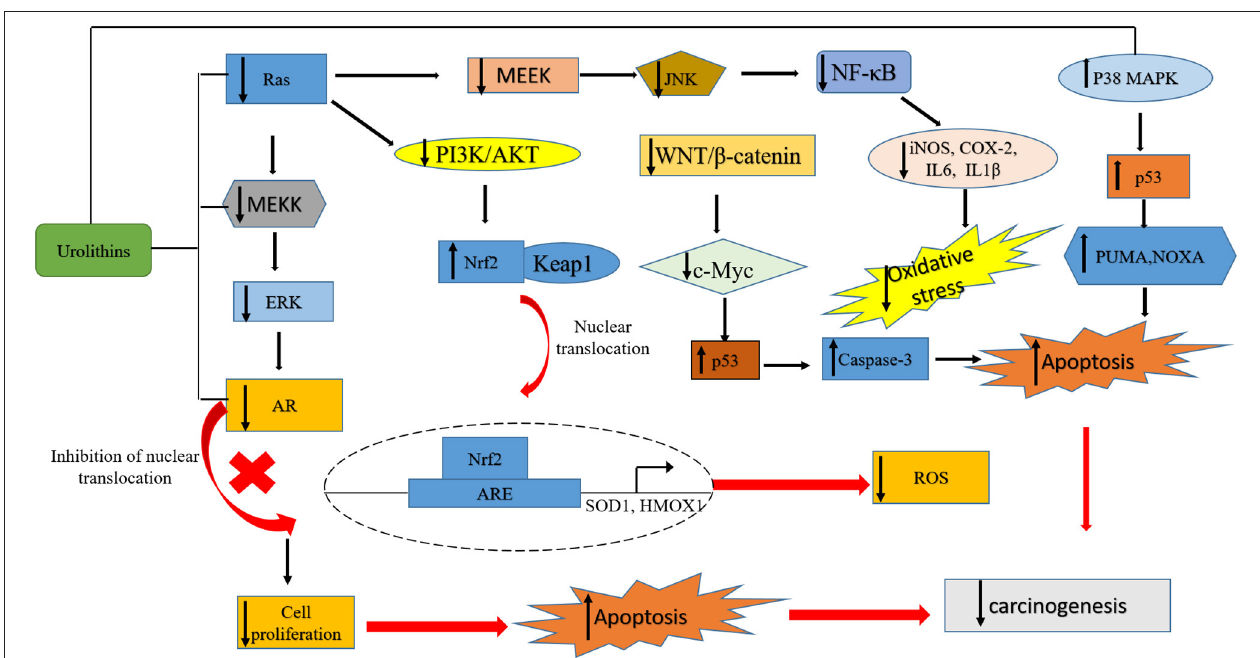
FIGURE 2 | A summary of pathways targeted by urolithins in mediating their anticancer activity. The urolithins mechanism of action involves decreased oxidative stress, cell cycle arrest, inhibition of survival pathways, induction of apoptosis, tumor suppression, promotion of autophagy and senescence, transcriptional regulation of oncogenes, inhibition of growth factor receptors, and upregulation of tumor suppressor